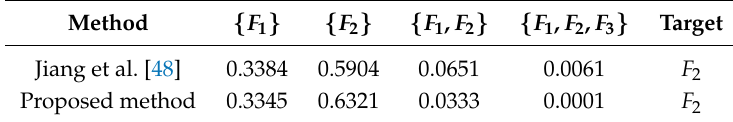
Table 12. Fusion results by using different combination methods at 3 X